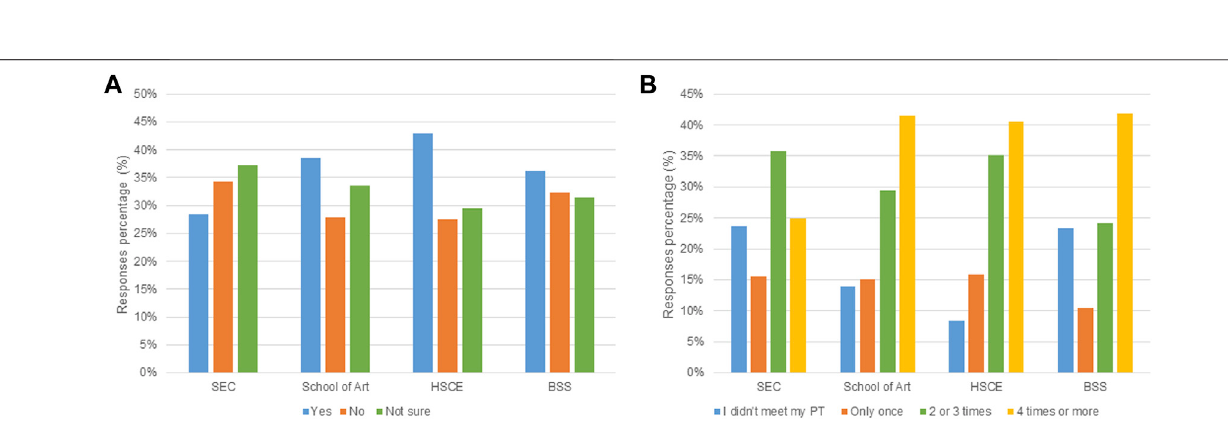
Frontiers in Education |